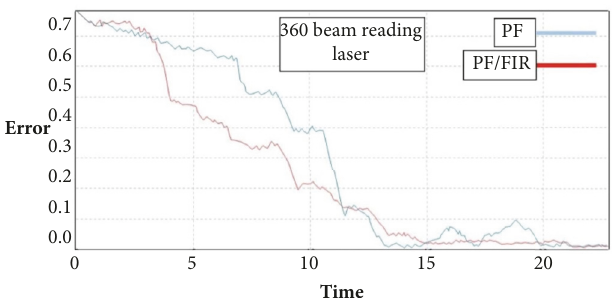
Figure 7: The Particle Filter only versus the hybrid against Particle Filter and Finite Impulse Response (PF/FIR) error with 360 laser reading points.